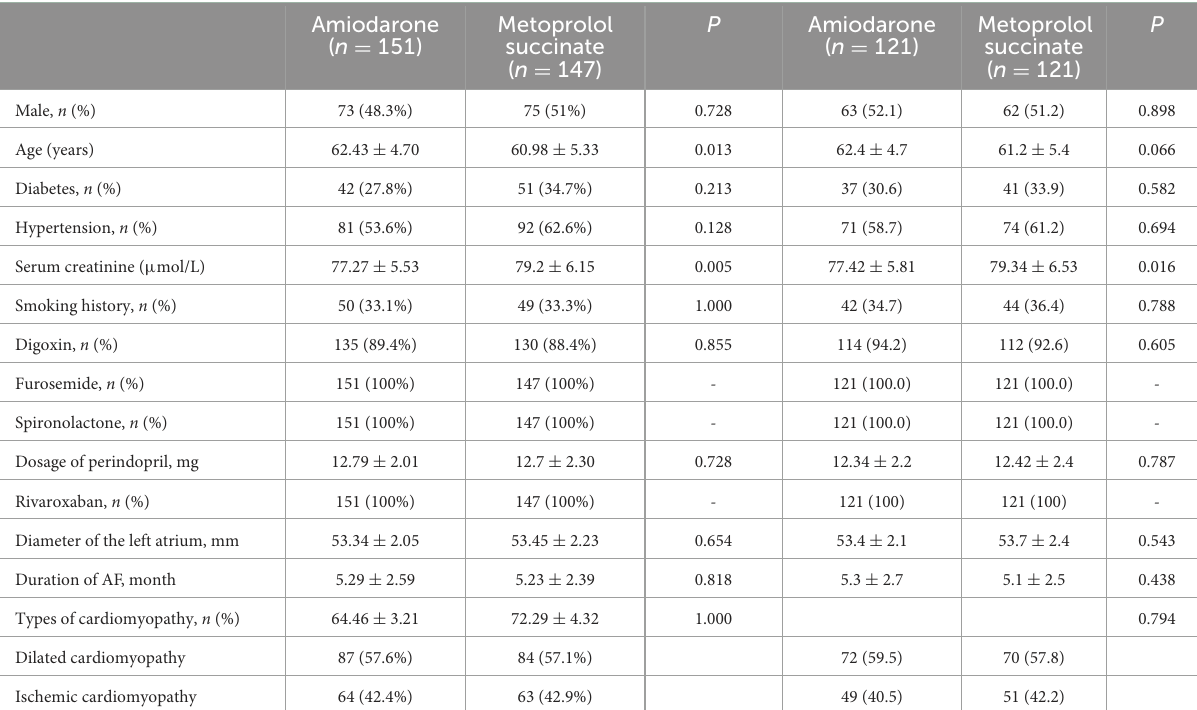
TABLE 1 Characteristics of the